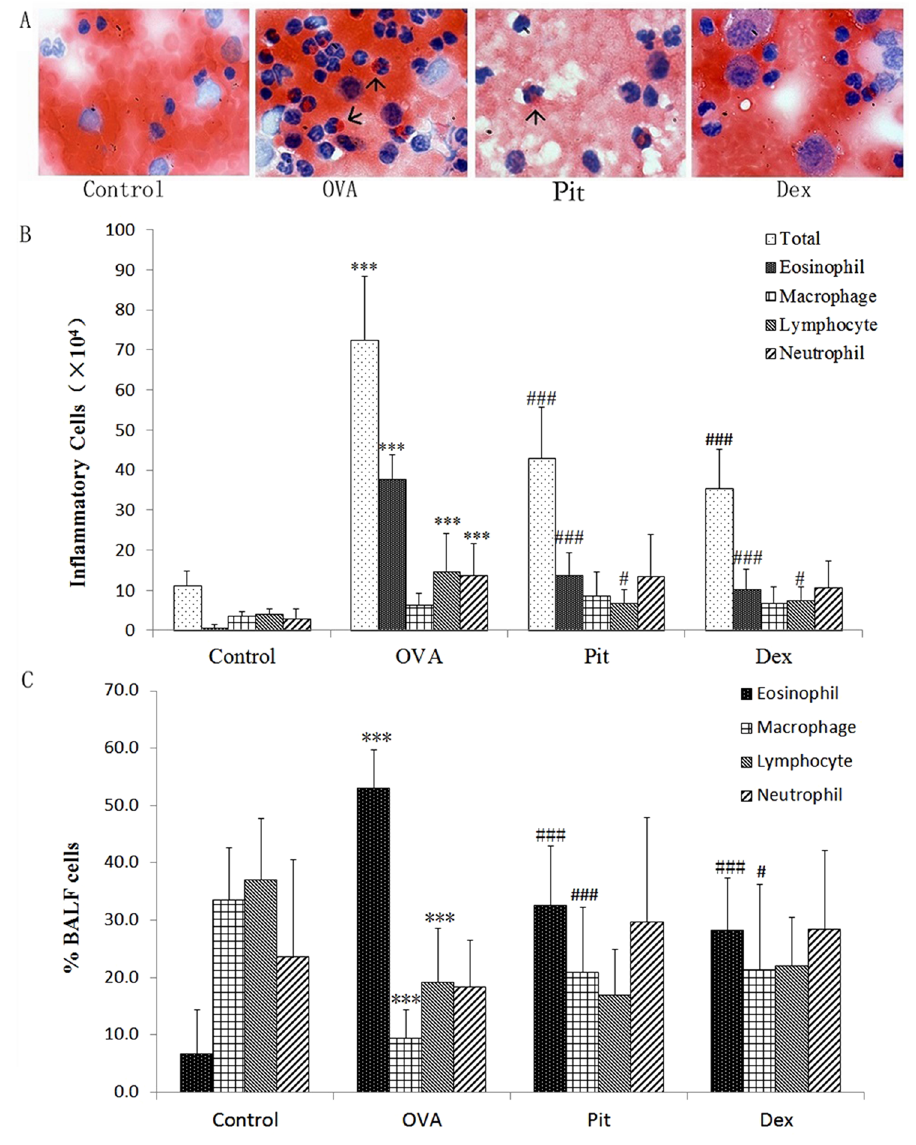
Figure 2. Effect of pitavastatin inhalation on the total and differential cell counts in BALF. The total number of inflammation-related BALF cells was counted using a haemocytometer, and differential cell counts in BALF were determined by staining tissue slides with H&E. Control: Lung sections from mice treated with aerosolized PBS. OVA: Lung sections from mice challenged with OVA and treated with PBS. Pit and Dex: Lung sections from mice challenged with OVA and treated with pitavastatin and dexamethasone, respectively. Values are expressed as the mean ± SD ( n = 10 per group). *** P < 0.001 compared with the control group; # P < 0.01 compared with the OVA group; ### P < 0.001 compared with the OVA group. ( A ) Representative images (400 × ) of H&E-stained BALF samples. ( B ) Changes in the number of inflammatory cells in the BALF of each group of mice with asthma. ( C ) Percentages of eosinophils, macrophages, lymphocytes, and